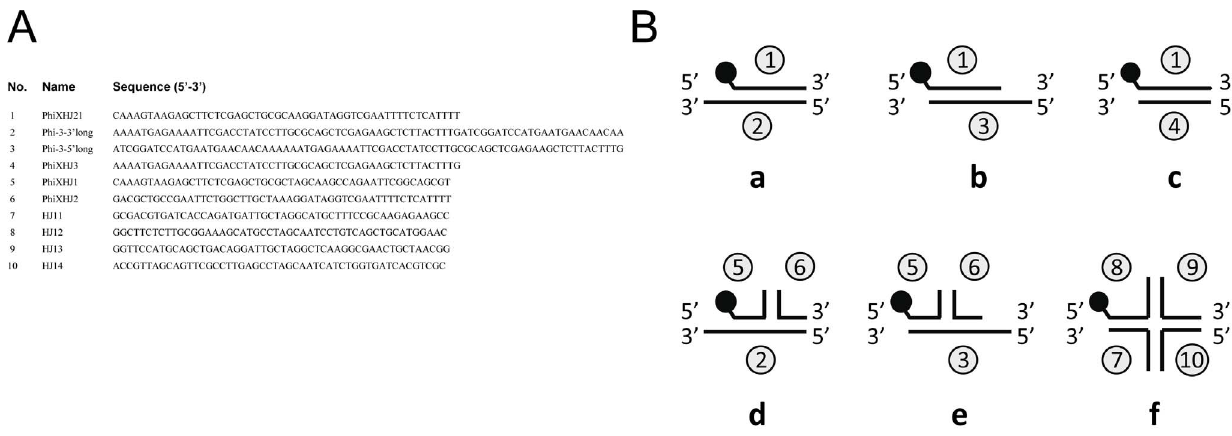
Figure 1. Sequences and structures of the DNA substrates used in this study. (A) Numbers, names and sequences of the oligonucleotides that were used to generate the DNA substrates shown in (B). (B) Schematic structures of the DNA substrates. Oligonucleotides are indicated as numbered lines. The numbers (in circles) correspond to the numbers of the oligonucleotides shown in (A). Substrates ‘a’ and ‘d’ contain a 3 9 24-nt ss extension, substrates ‘b’ and ‘e’ contain a 5 9 24-nt ss extension, and substrates ‘c’ and ‘f’ are blunt-ended. The black dots represent 6-FAM labels at the 5 9 end of the oligonucleotides.